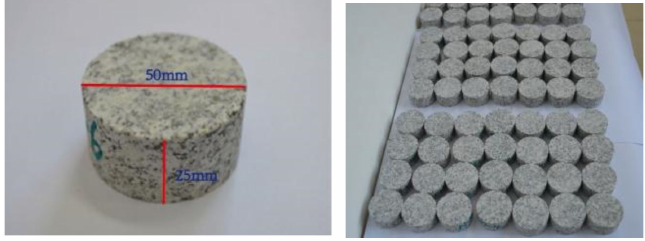
Figure 4. Processed granite